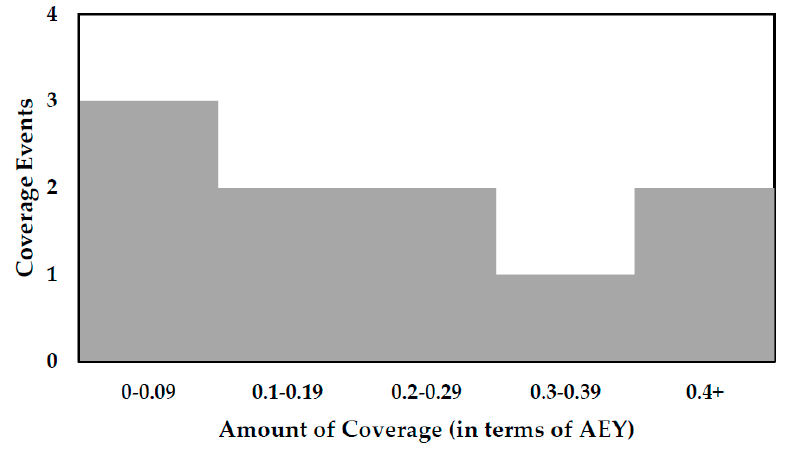
Figure 4. Frequency and size of coverage events derived from payout scheme (Figure 3).